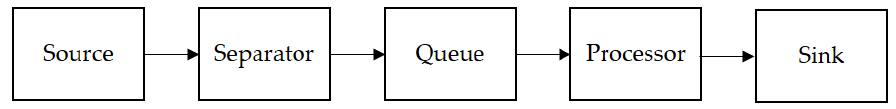
Figure 6. Simplified model, basic simulation mechanisms. Source: own elaboration.